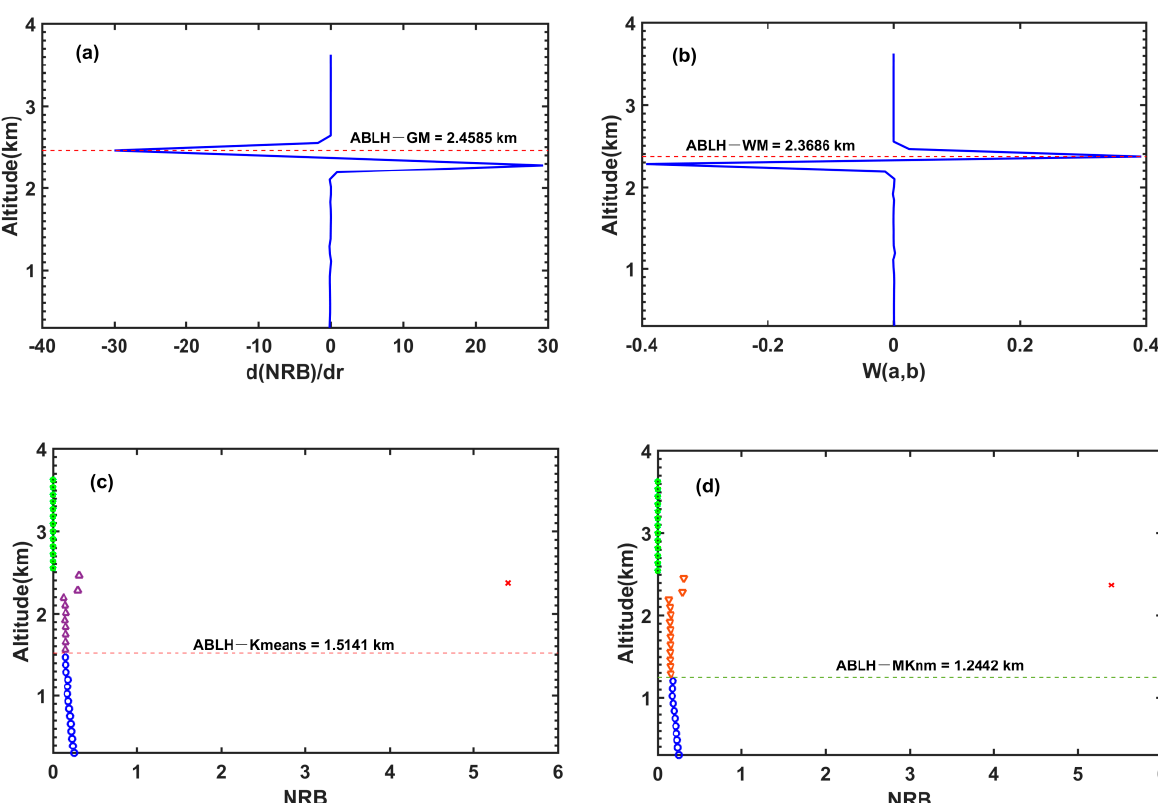
Figure 6. The ABLH obtained by four methods under cloudy conditions.